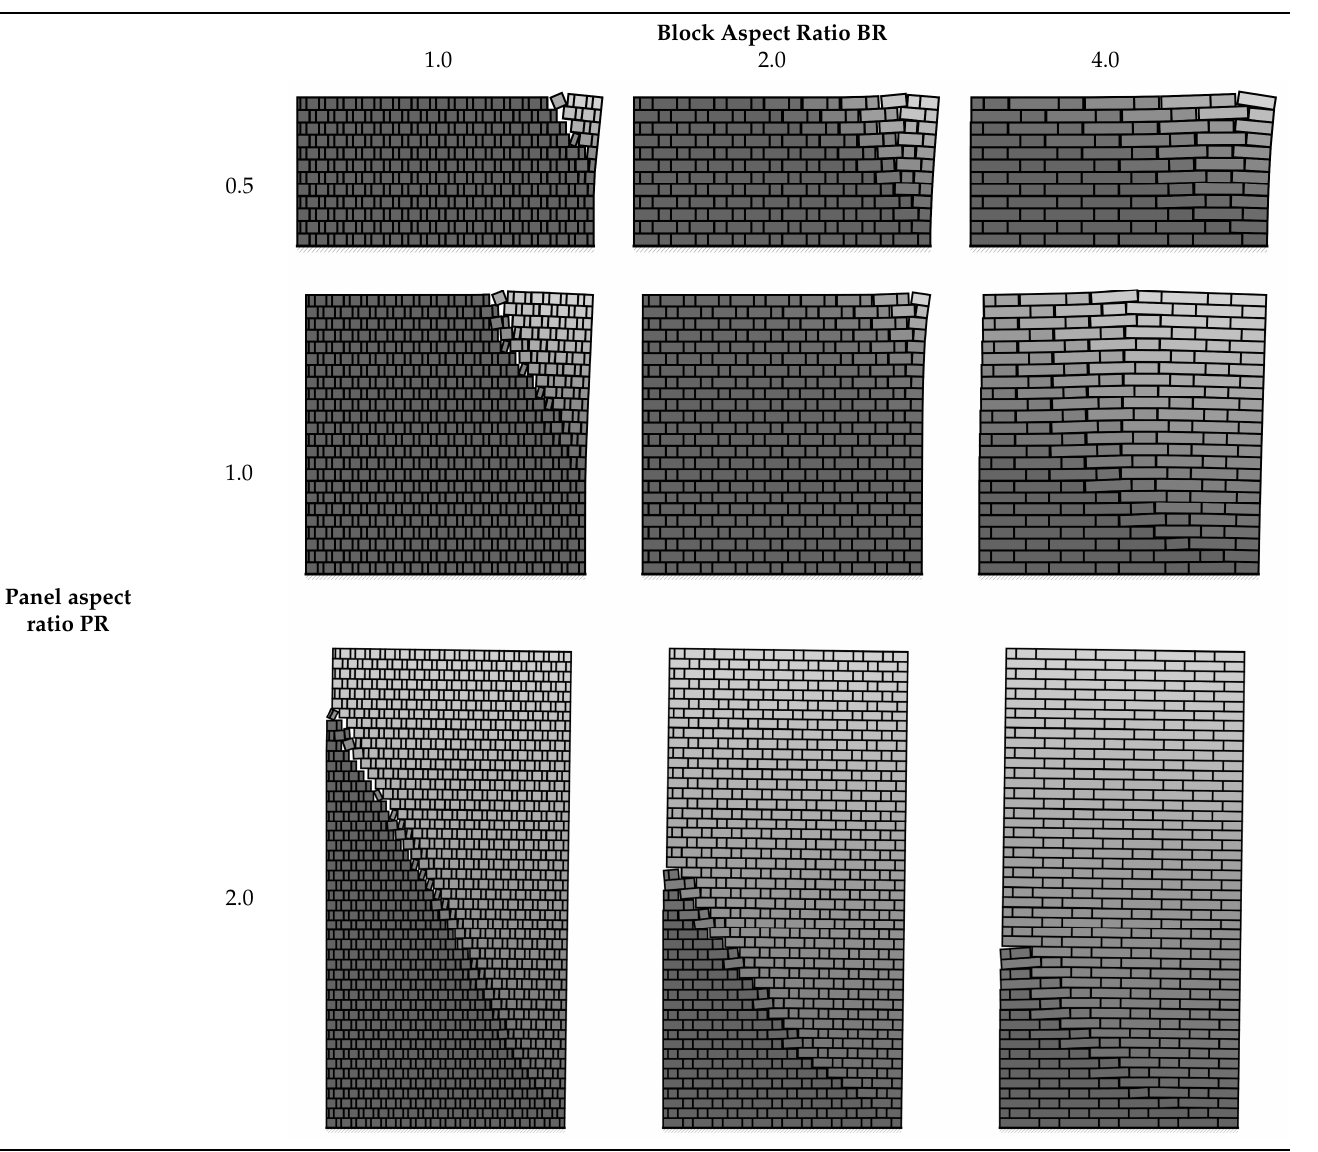
Table A6. Failure Mechanisms for Flemish Bond with µ = 0.80.